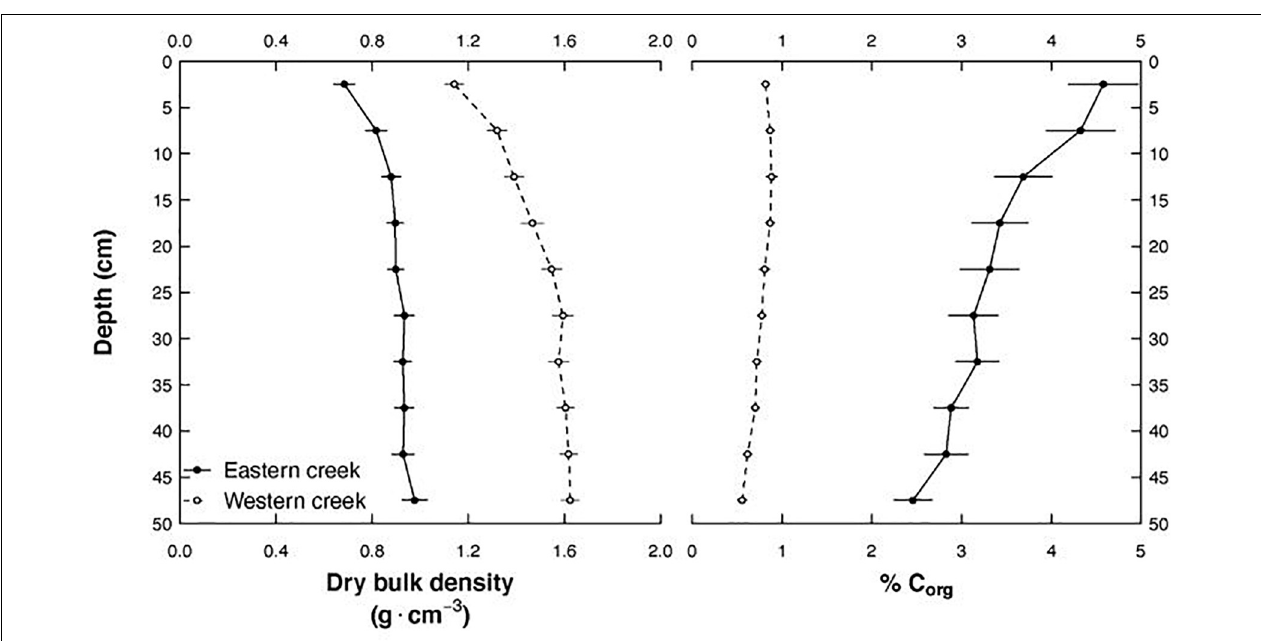
difference among the species C org [ F ( 7 , 79 ) = 20.28, p < 0.001]. Sediment C org also varied between the creeks, with the Eastern creek recording higher values at 258.21 ± 90.12 Mg C ha − 1 (range = 117.85–544.65 Mg C ha − 1 ) while the Western creek